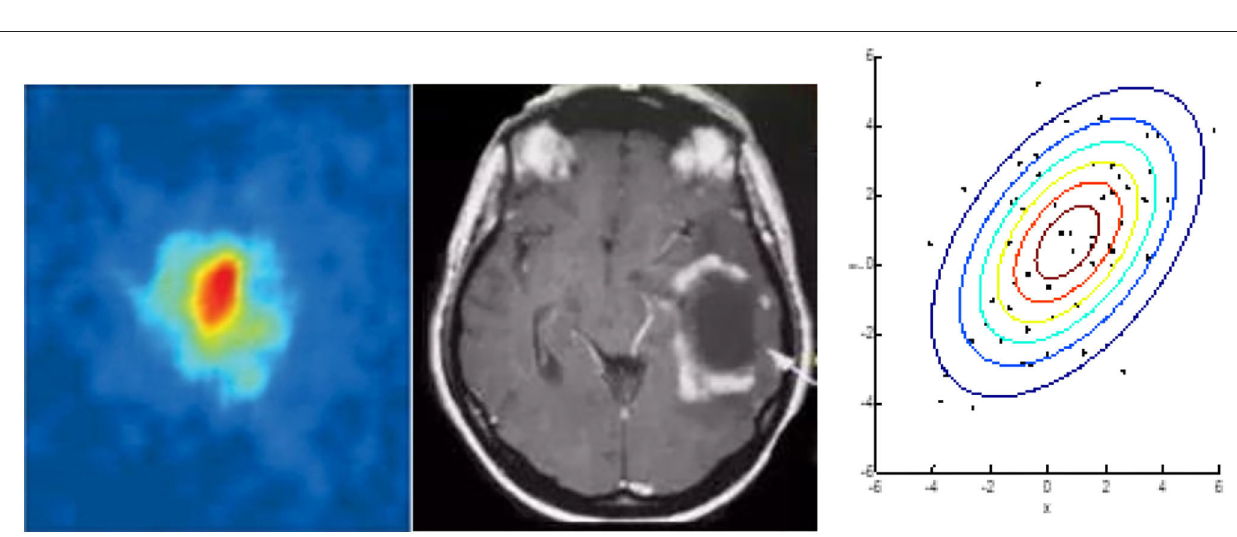
FIGURE 6 | BEC image (Left), Glioma image (Middle), and BEC kernel in SVM